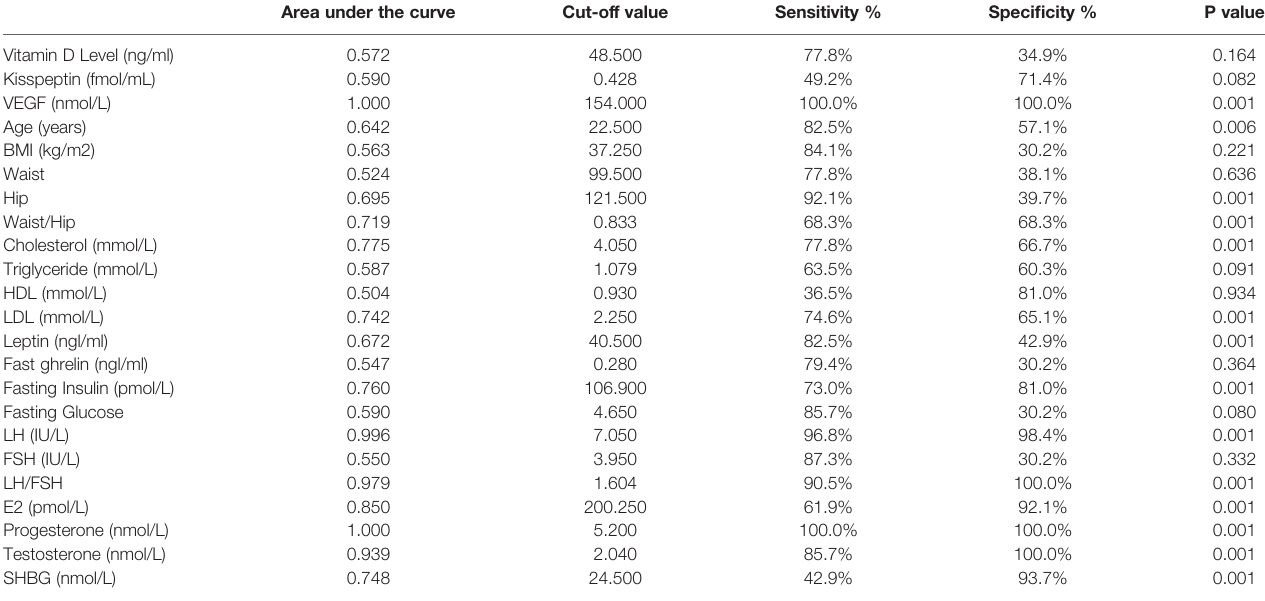
TABLE 7 | The AOC value, sensitivity and speci fi city of all parameters in obese PCOS group.